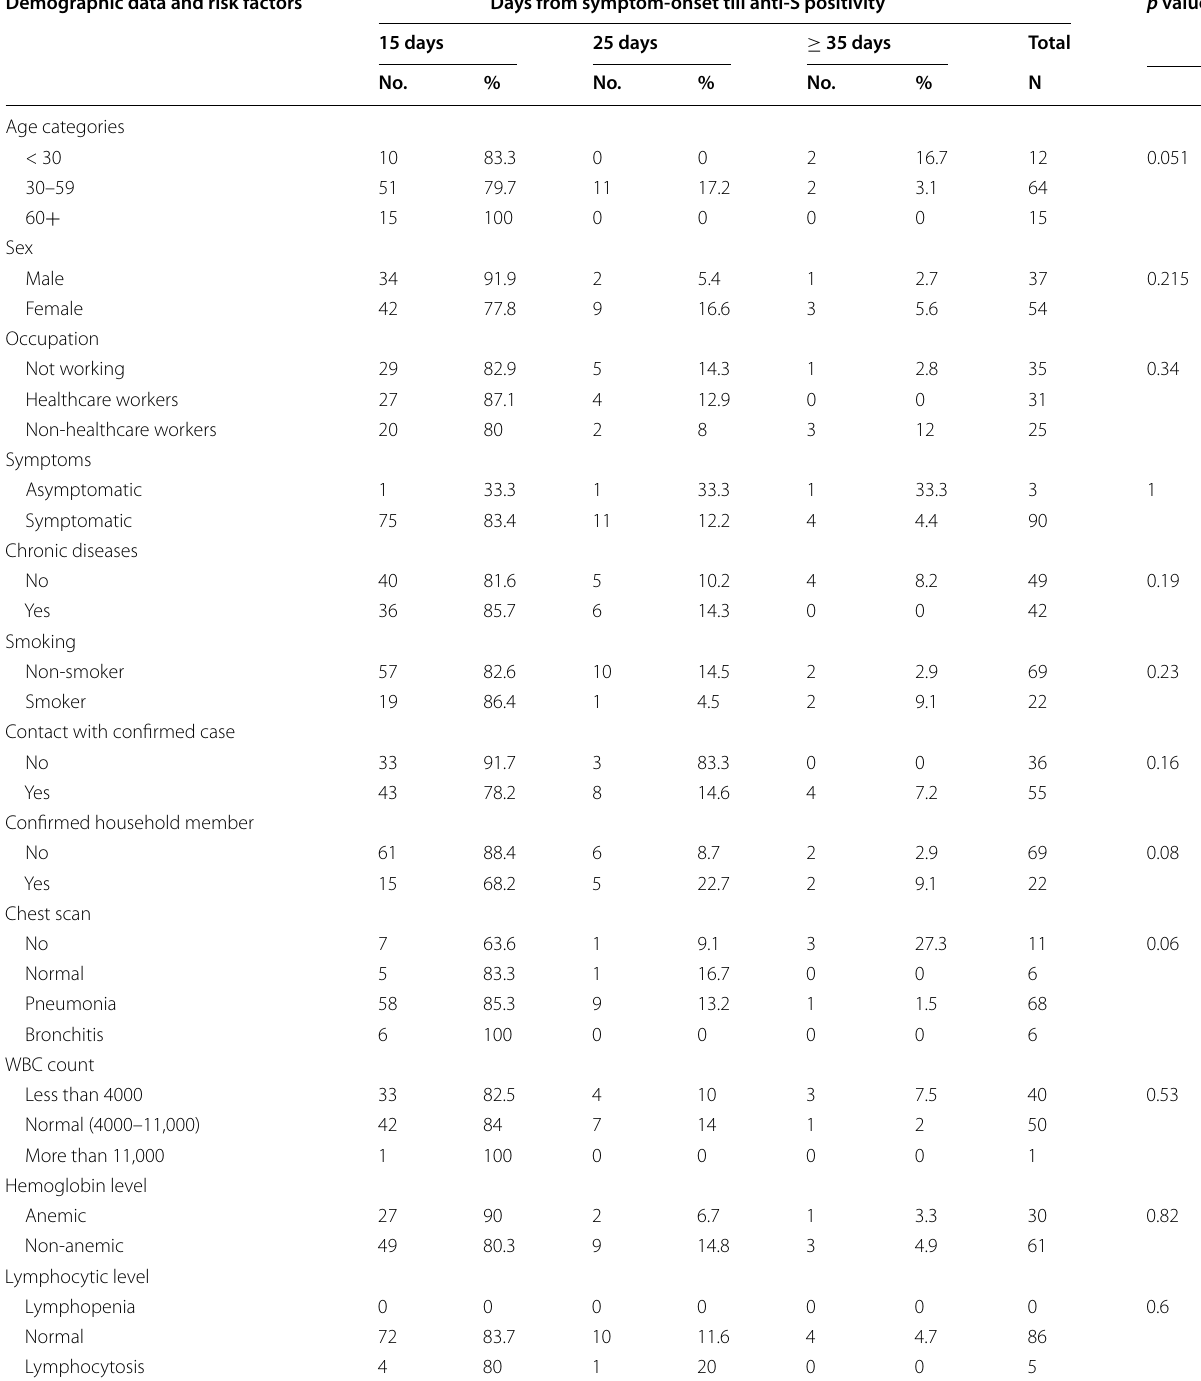
Table 4 Demographic data and risk factors of 91 COVID-19 home-isolated patients according to the onset of positivity of SARS-CoV-2